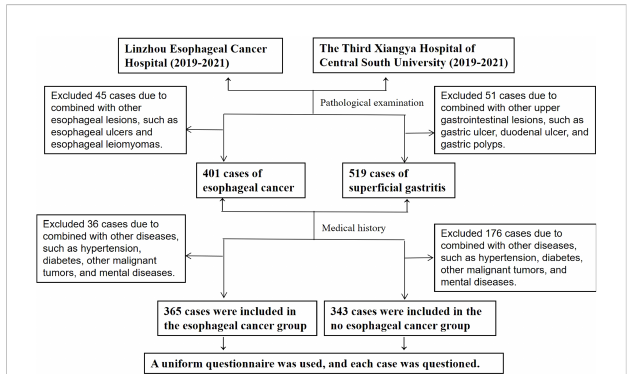
FIGURE 1 Study recruitment fl owchart. In total, 365 patients with esophageal cancer con fi rmed by pathological examination at Linzhou City (Lin County) Esophageal Cancer Hospital in Henan Province and The Third Xiangya Hospital of Central South University from January 2019 to January 2021 were selected as the case group, and 343 cases of super fi cial gastritis screened by gastroscopy and pathological examination in the same two hospitals during the same period were selected as the control group.